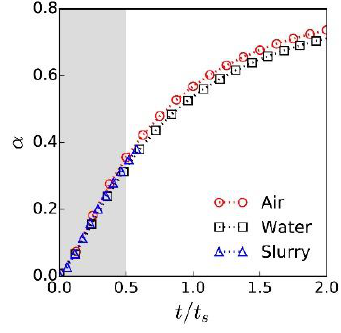
Fig. 3. The evolution of 𝛼 in dimensionless time. Shaded region represents the span of time in which the segregation in different ambient fluids occur at the same pace.